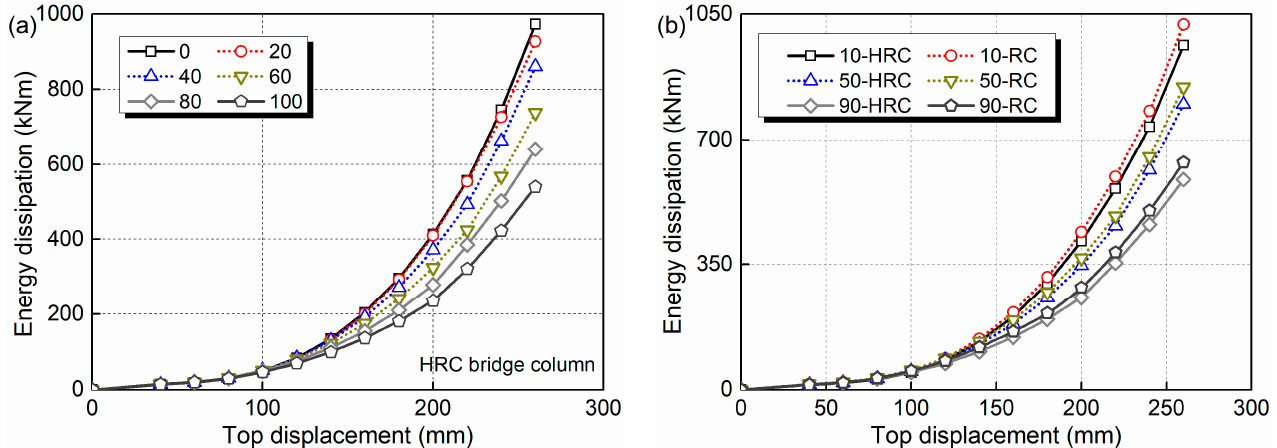
Figure 10. Time-dependent energy dissipations of: ( a ) HRC bridge column; ( b ) HRC and RC bridge column.